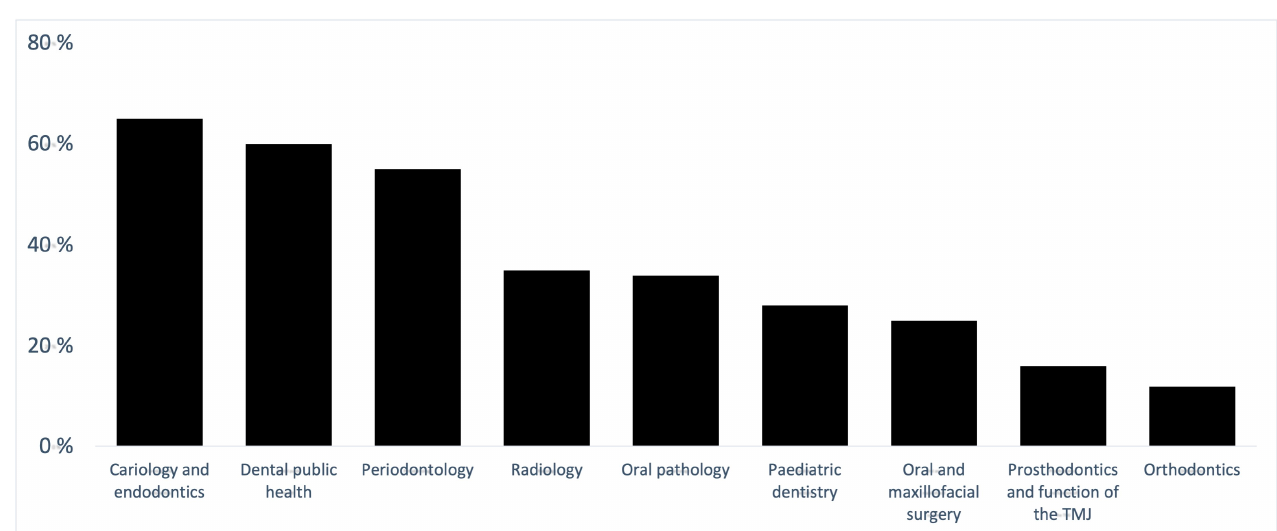
Figure 1. Elements proposed for the preclinical study phase of the dental curriculum (n = 110).